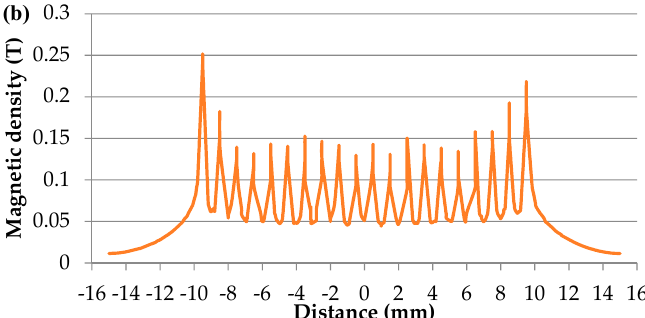
Figure 2. ( a ) Simulation of the magnetic field in the fluidic channel; ( b ) the magnetic density from point A to point B.